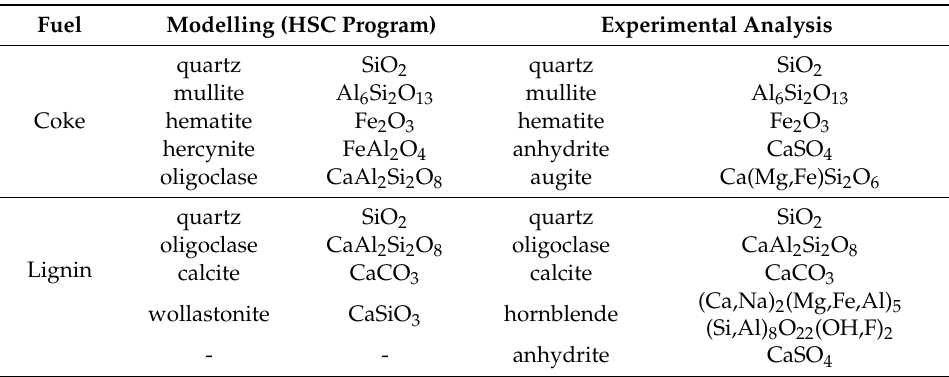
Table 4. Comparison of fuel ash phase composition.